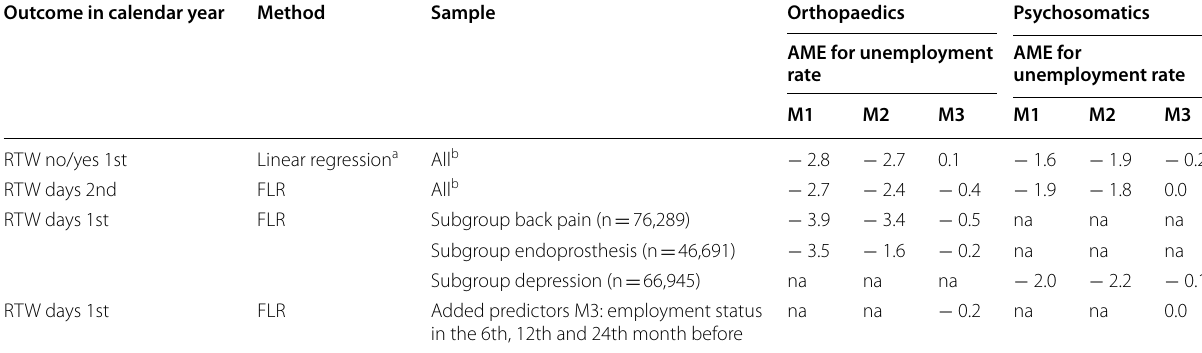
Table 5 Robustness